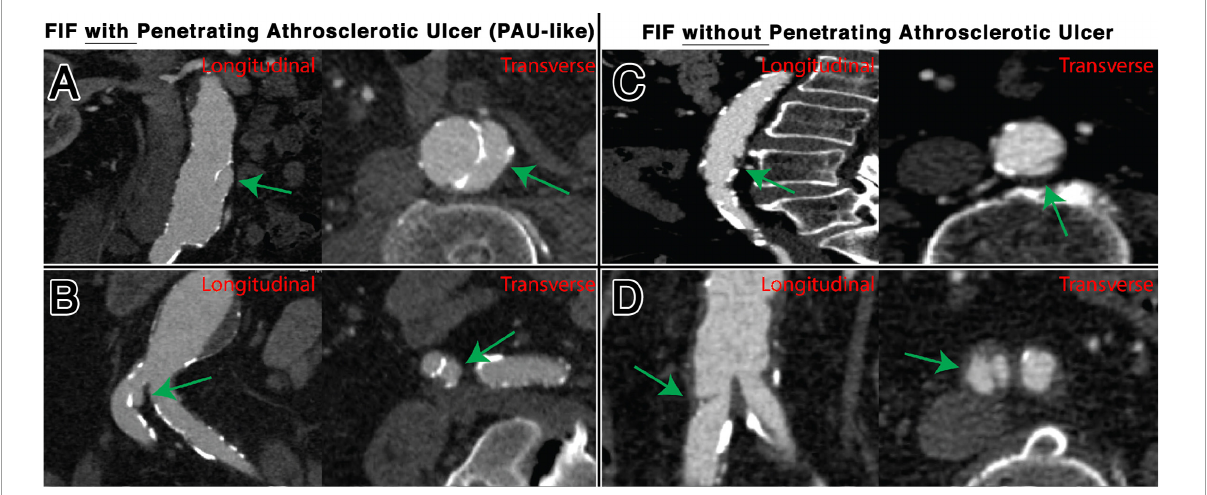
FIGURE5 Representative examples of FIFs, with and without associated PAU, located in the abdominal aorta, shown transverse and longitudinal plane. Locations and characteristics of FIFs shown include infrarenal segment with PAU (A) , common iliac artery with PAU (B) , infrarenal segment without PAU (C) , and common iliac artery without PAU (D)